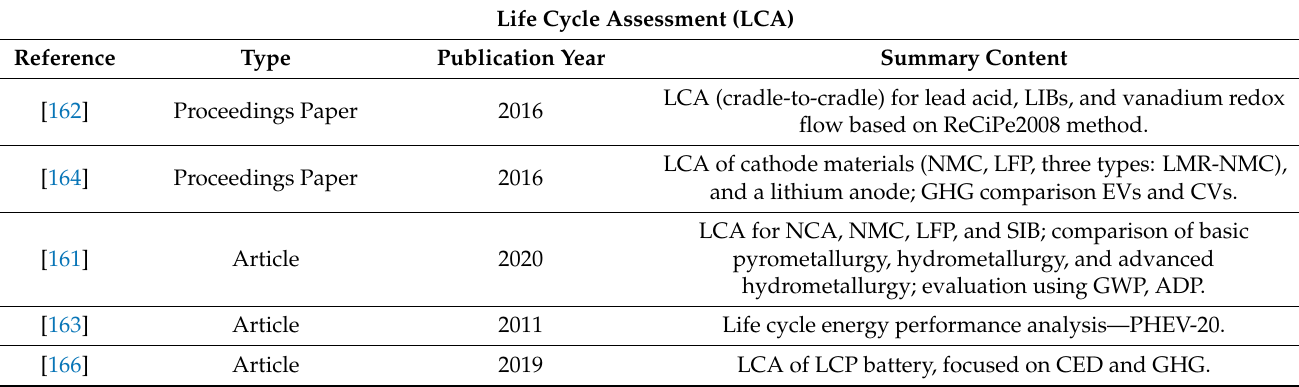
Table A3. Assessed literature in review for “LCA” category.